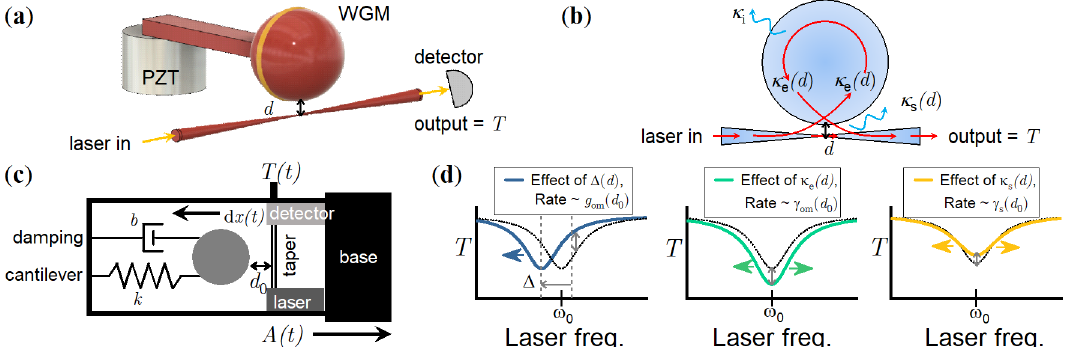
Figure 1. ( a ) Optical coupling between the tapered waveguide and the WGM microsphere-cantilever where d is the coupling